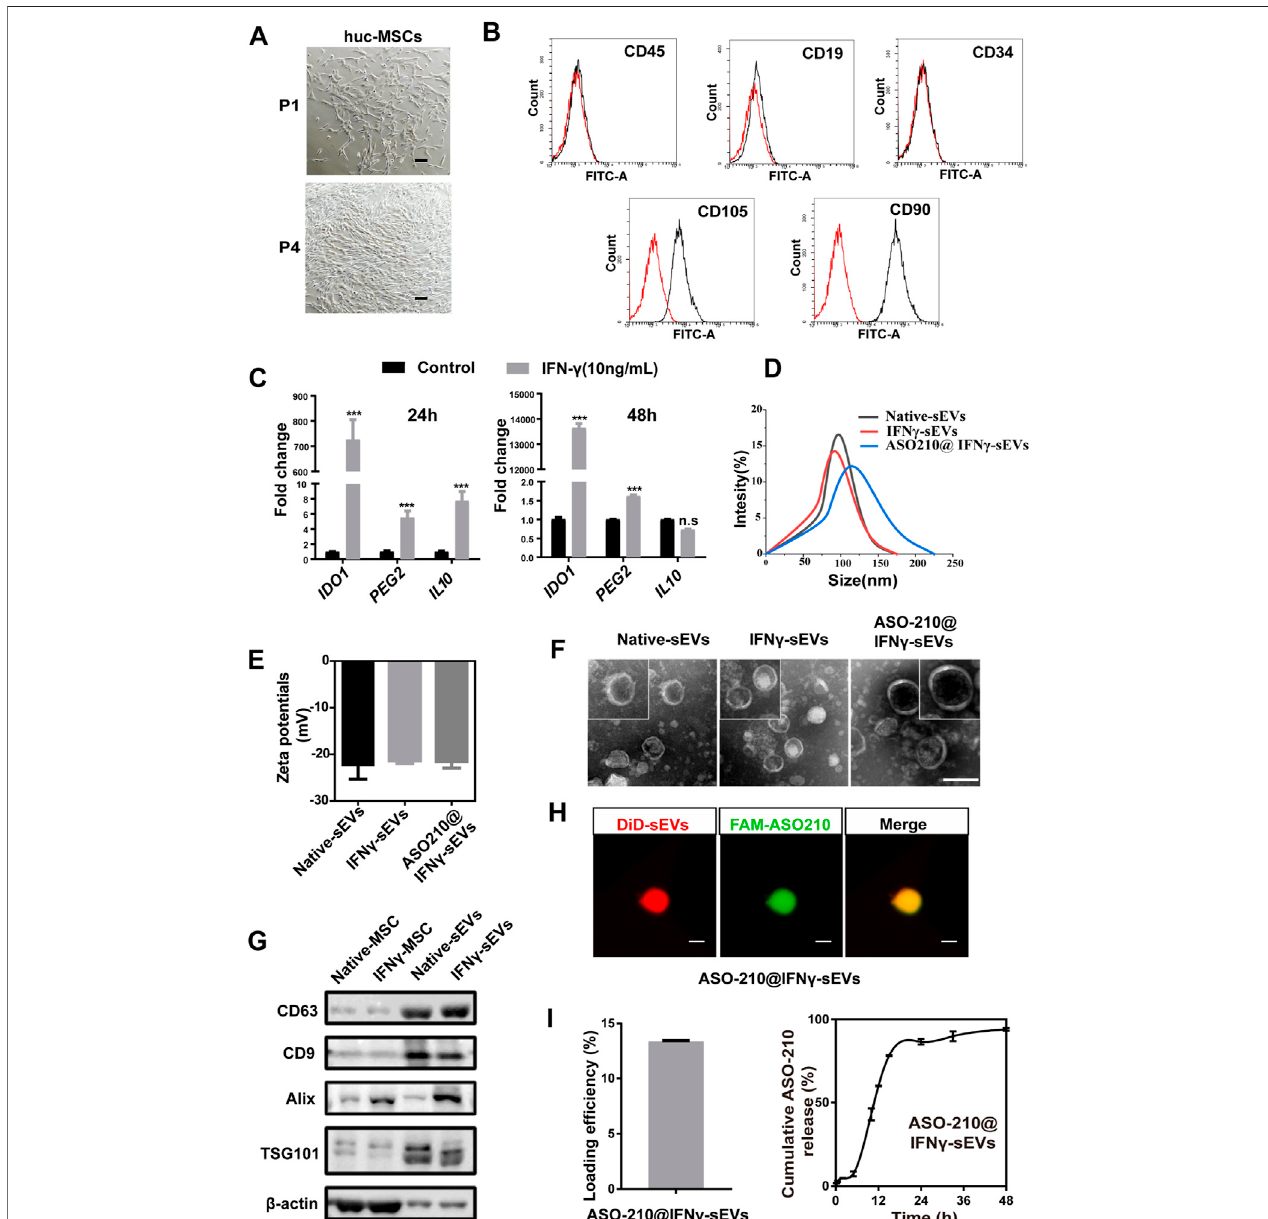
FIGURE 1 | Preparation and characterization of huc-MSC-derived sEVs. (A) The spindle-shaped, fi broblast-like morphology of isolated huc-MSCs (P1 and P4). Scale bar: 100 μ m. (B) Flow cytometry analysis of CD9, CD19, CD34, CD90, and CD105 expression on the huc-MSC surface. (C) qPCR of IDO1 , PEG2 , and IL10 mRNA levels in huc-MSC stimulated with or without IFN- γ (n = 3). (D,E) The size distribution and zeta potential of native sEVs, IFN γ -sEVs, and ASO-210@ IFN γ -sEVs were measured by DLS (n = 3). (F) Representative TEM images of native sEVs, IFN γ -sEVs, and ASO-210@IFN γ -sEVs. Scale bar: 100 nm. (G) Western blotting of MSC-derivedsEVsforCD9,CD63,TSG101,andAlix. (H) Representativeconfocalimagesofpre-stainedDiD-sEVs(red)colocalizedwithFAM-labeledASO-210(green). Scale bar: 200 nm. Error bar, mean ± SD. n.s representsno signi fi cance, * p < 0.05, ** p < 0.01, and *** p < 0.001. (I) ASO-210 loading ef fi ciency and release ef fi ciency of ASO-210@IFN γ